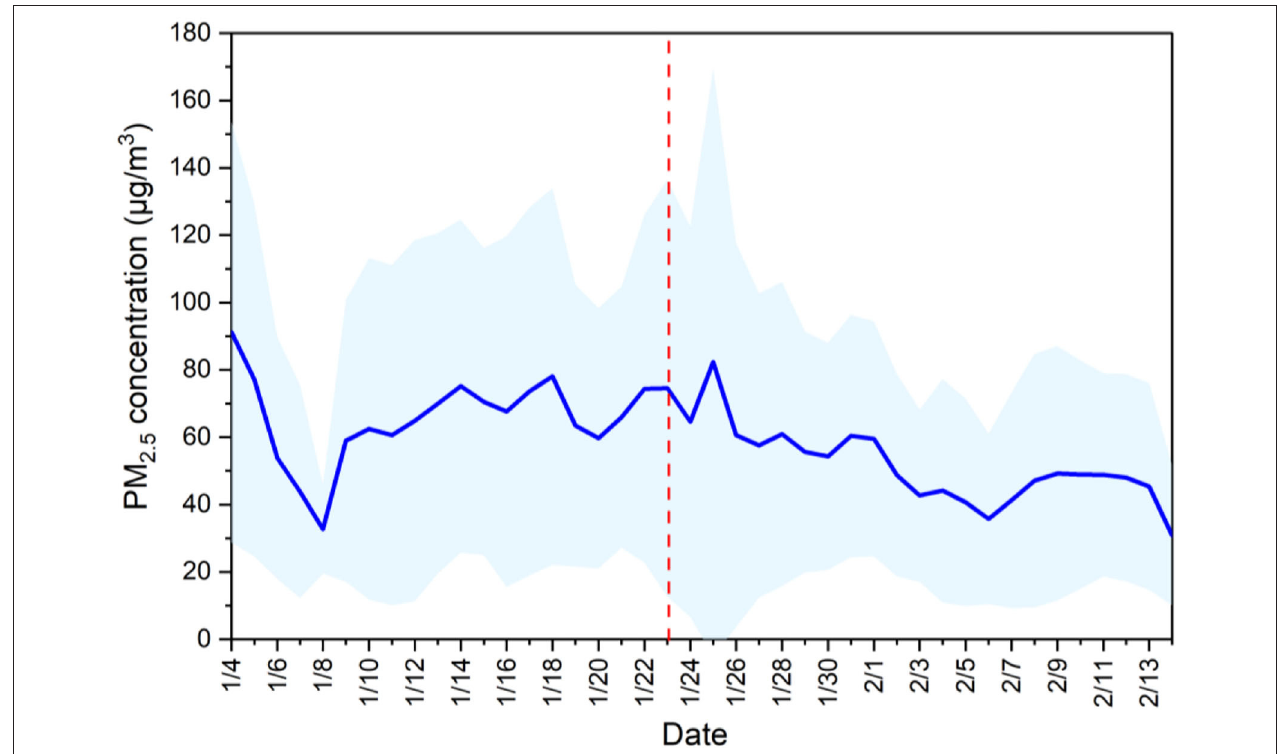
FIGURE 1 | Time-variation in daily PM 2.5 concentrations Chinese cities before and after lockdown measures were implemented in response to the outbreak of COVID-19. The red line represents the day that lockdown measures began in Wuhan, and shaded blue denote the standard deviations.